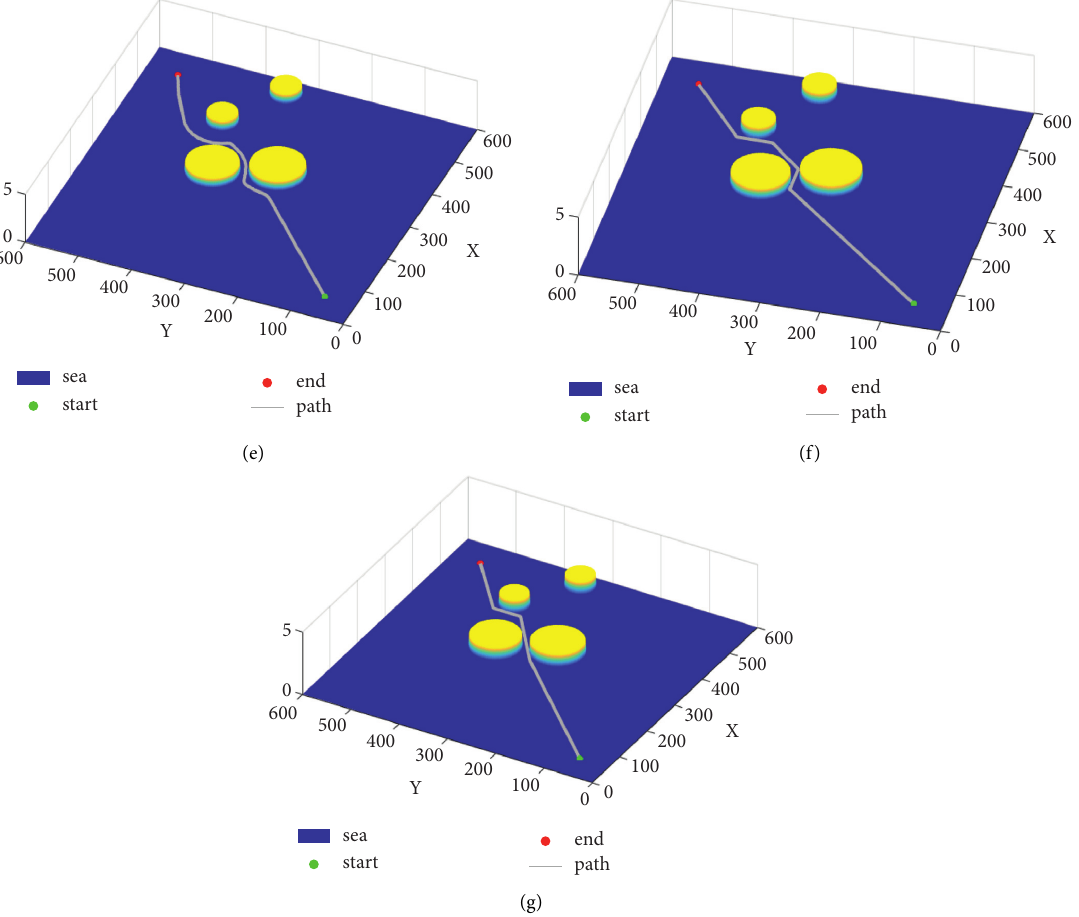
Figure 12: Paths planned by different algorithms. (a) Path planned by LSTM + DDPG algorithm. (b) Path planned by DDPG algorithm. (c) Path planned by RRTalgorithm. (d) Path planned by RRT ∗ algorithm. (e) Path planned by APF algorithm. (f) A ∗ algorithm-planned path. (g) Path planned by BUG2 algorithm. Table 3: Parameter settings of the comparison algorithm. Algorithm Parameter